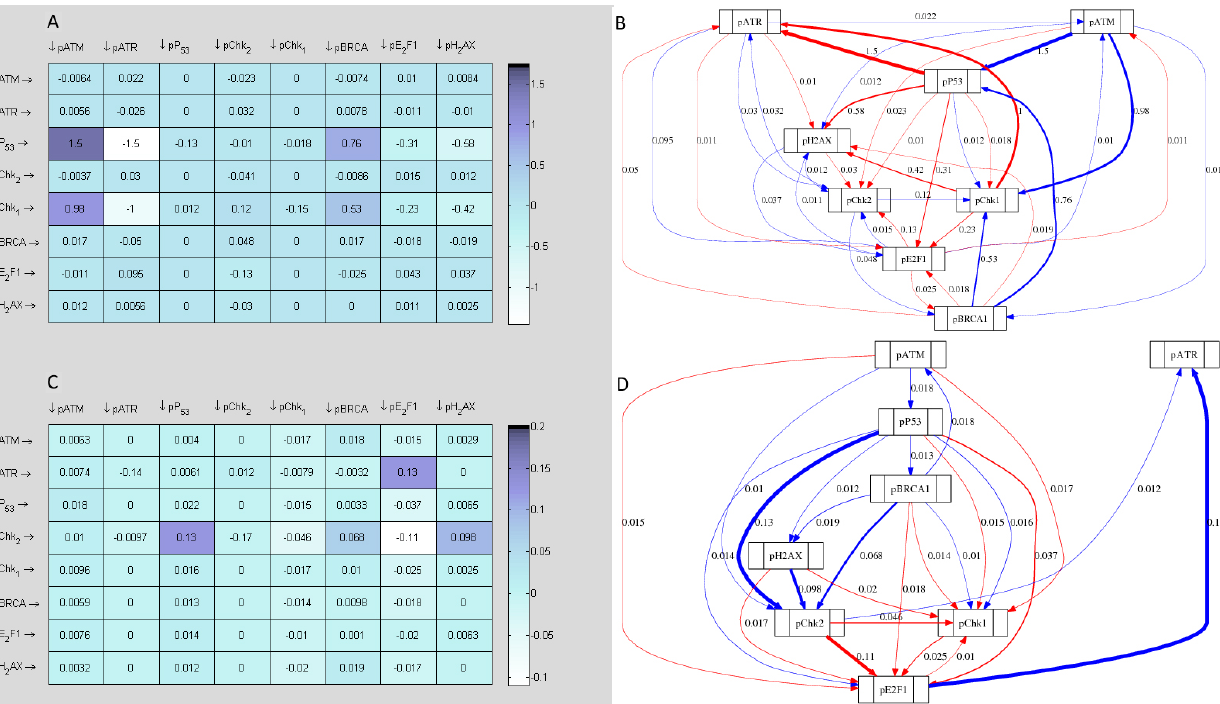
Figure 11. Constructed network models of time series data of the DDR pathway: (A) - inferred interaction matrix of 0 . 1 µM DOX time series data (without ATM inhibition); (B) - derived topological map (network of interactions) of 0 . 1 µM DOX time series data (without ATM inhibition); (C) - inferred interaction matrix of 0 . 1 µM DOX+KU time series data (with ATM inhibition); and (D) - derived topological map of 0 . 1 µM DOX+KU time series data (with ATM